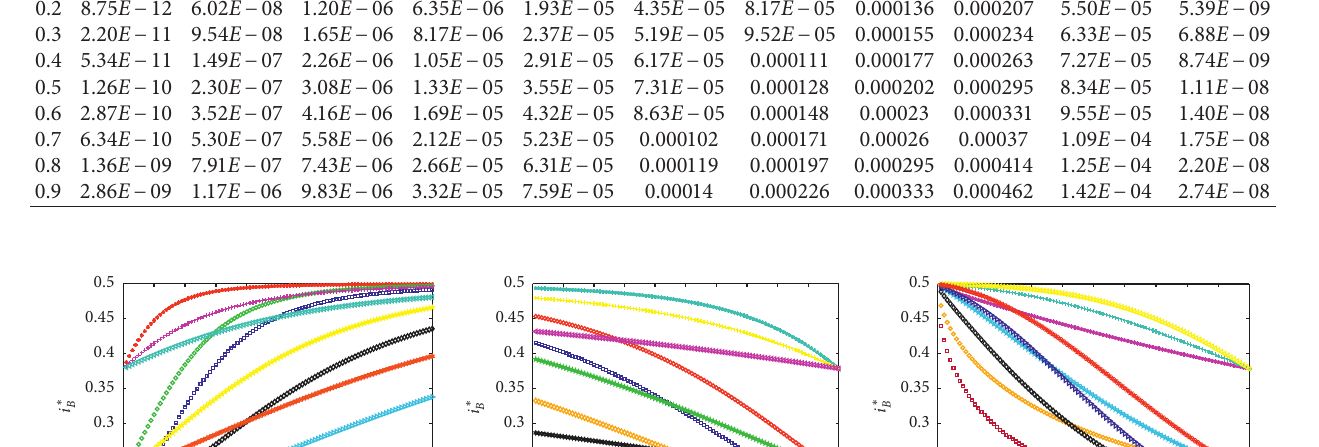
Table 9: Bank network under the index network—the sensitivity analysis of the influence of ρ and ω on λ ∗ ρ